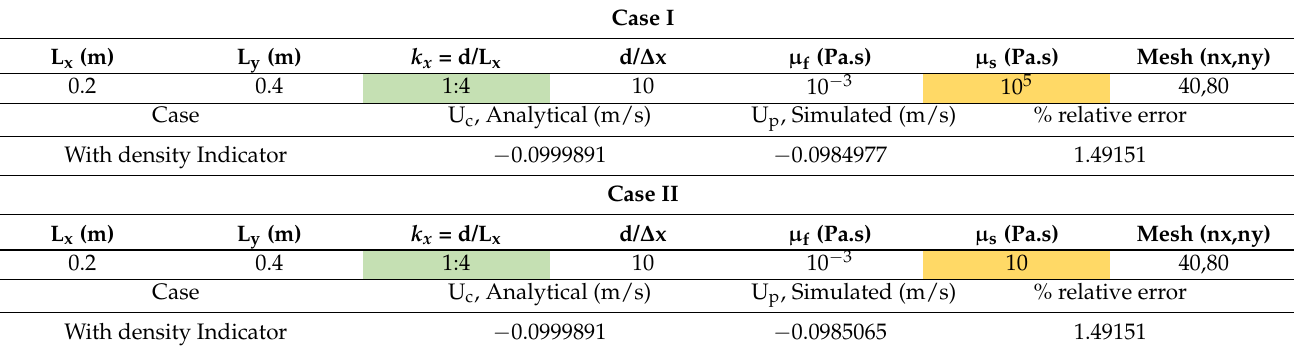
Table A4. Effect of Viscosity.